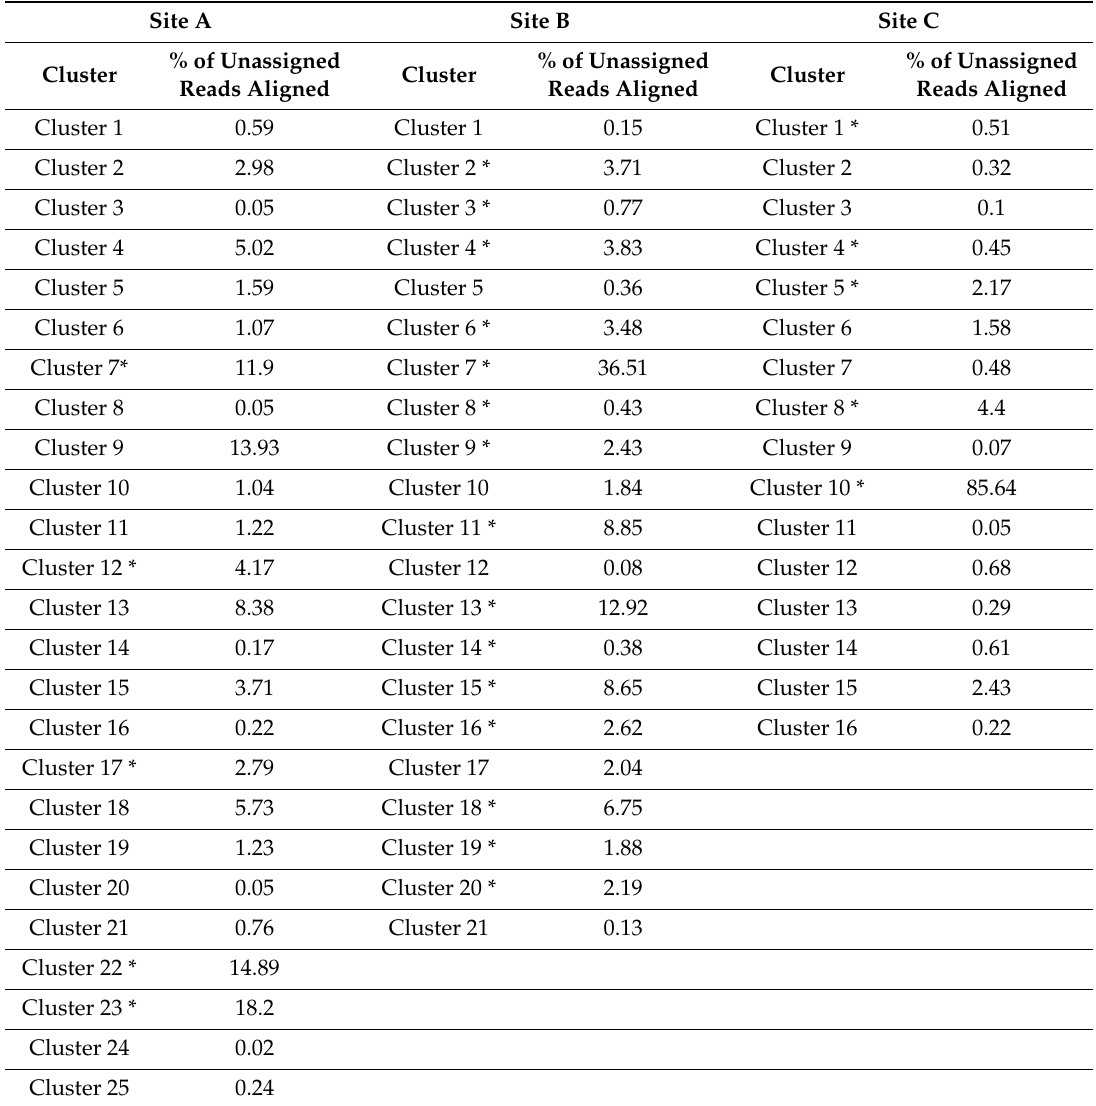
Table 4. Percent of reads without match vs. NT aligned to each